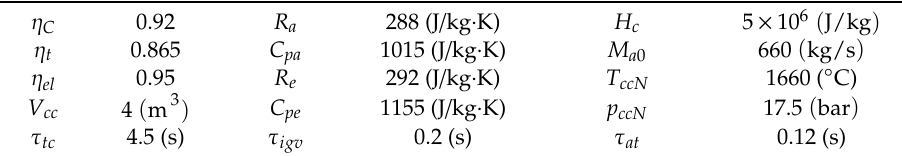
Table 4. GT system model